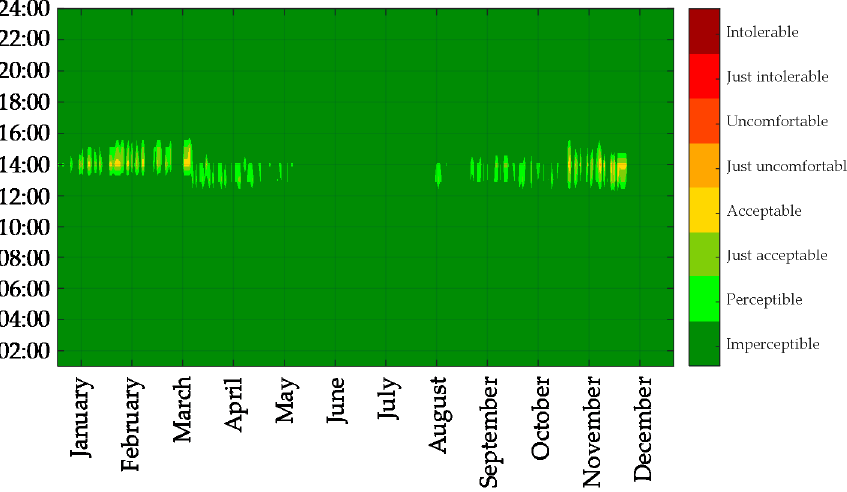
Figure 13. Annual DGI values in an office zone with south orientation in Stockholm.